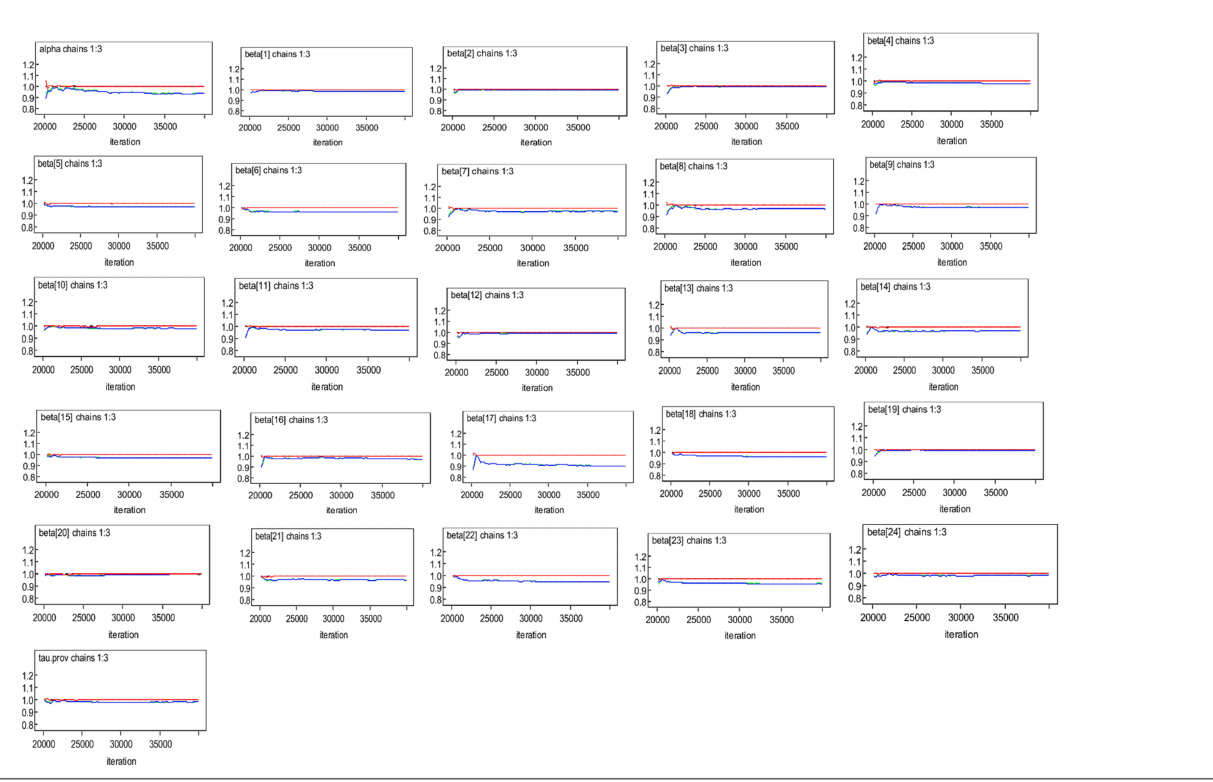
Figure A2. BGR convergence plots for Bayesian MLM with non-informative